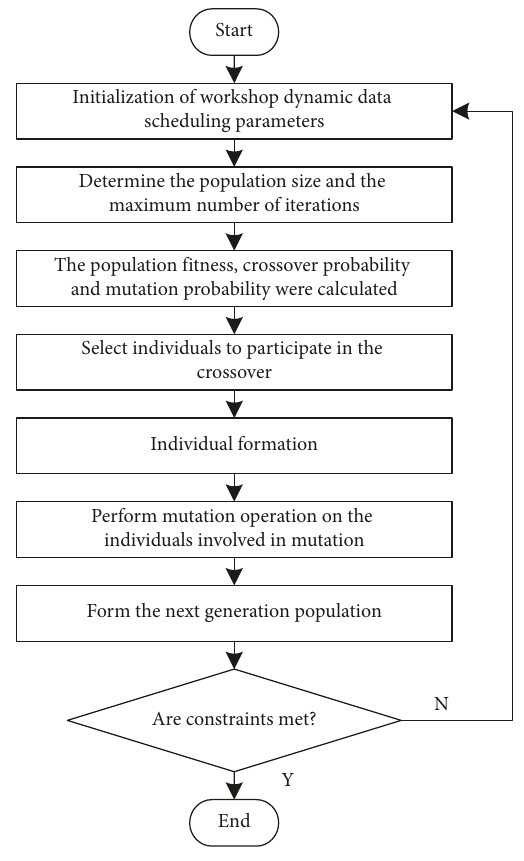
Figure 5: Operation flow chart of the CGA